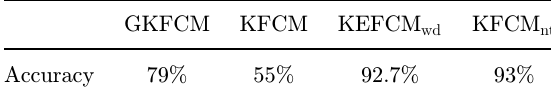
Table 7. Error Matrix on Breast Cancer Dataset. GKFCM KFCM KEFCM wd KFCM nt Accuracy 79% 55%